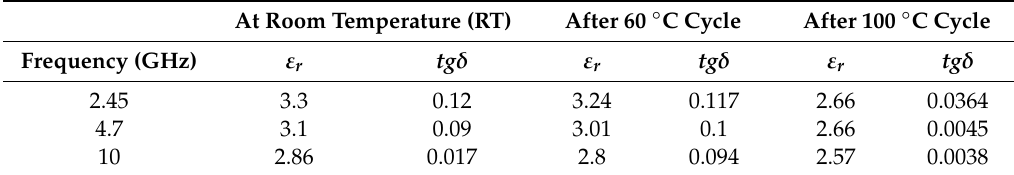
Table 1. Evolution of electrical properties.